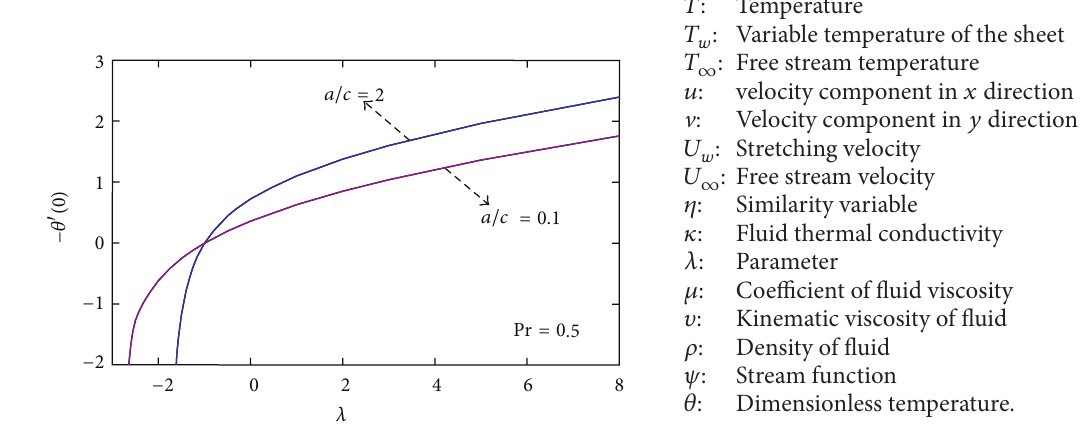
Figure 14: Values of −𝜃 󸀠 (0) versus 𝜆 for various values of 𝑎/𝑐 with Pr = 0.5 .